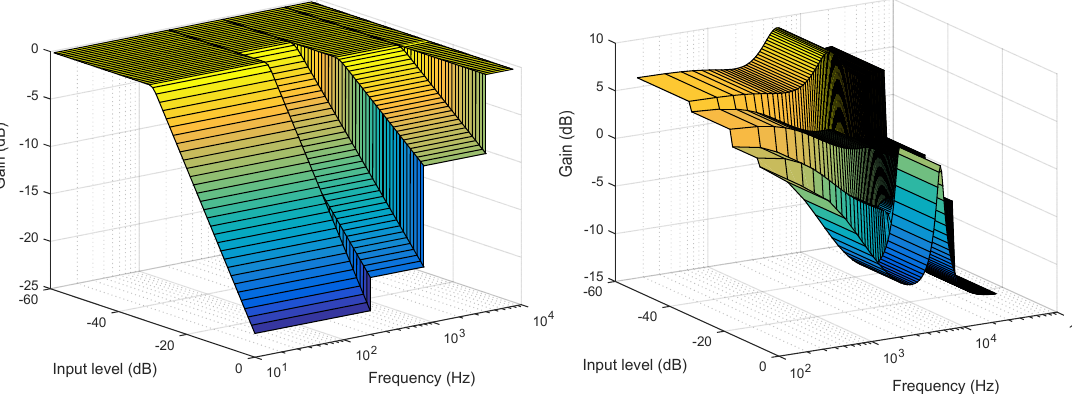
Figure 15. Input-output characteristics of a 4-band compressor ( left ) and a 4-band dynamic equalizer ( right ), showing dependence on both input signal level and